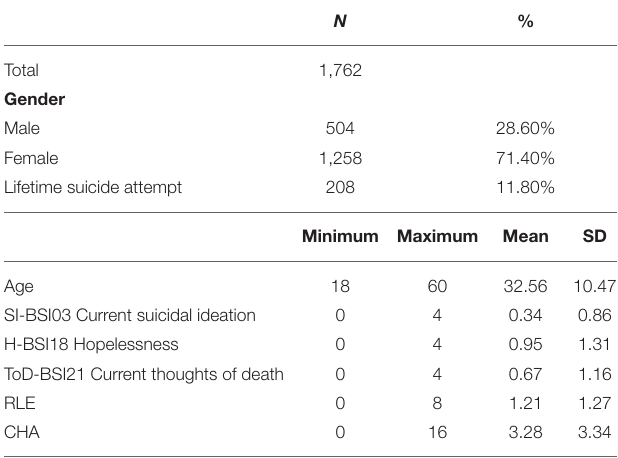
TABLE 1 | Characteristics of the